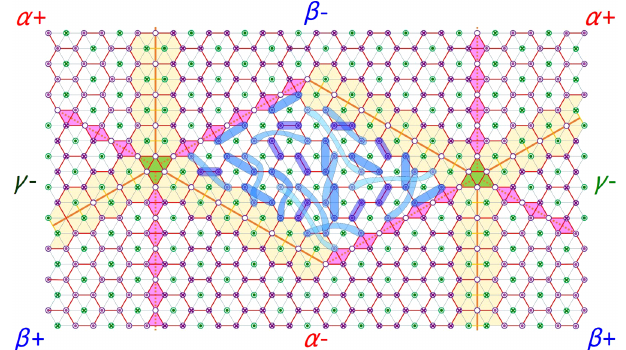
5. A schematic in-plane structure of TbInO 3 describing the structural and ferroelectric domains and domain walls. The innermost region ( γ þ ) shows a snapshot of entangled spins (blue loops) in the spin liquid state. Other domains are shown as ( α , β , γ , þ , − ), and they are delineated by domain walls with full and dashed orange lines, respectively. Only Tb1 and Tb2 ions are shown as green and purple circles, respectively. Dot and crossed circles denote the up and down displacements of Tb ions along the c axis, respectively. Blue and red lines are nearest-neighbor Tb 1 ─ Tb 2 and Tb 2 ─ Tb 2 bonds, respectively. There are two types of domain boundaries: a corner-sharing type (lines of magenta parallelograms) and an elongated type (lines of light yellow